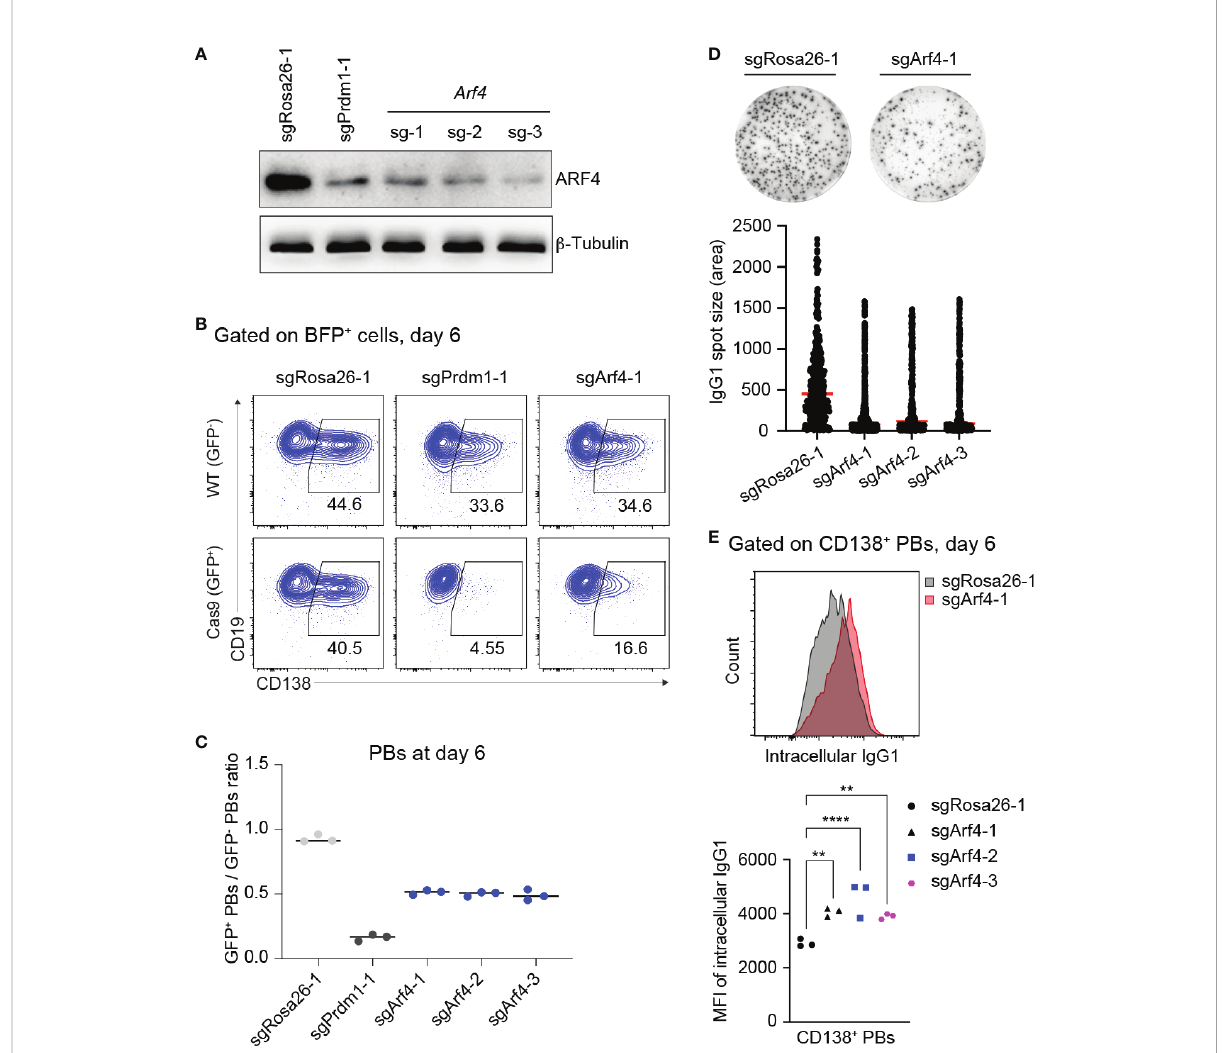
FIGURE 4 Loss of ARF4 arrests PB formation and blocks antibody secretion. (A) Western blotting for ARF4 protein showing gene KO ef fi ciencies of sgRNAs targeting the Arf4 gene. SgRosa26-1 and sgPrdm1-1 were used as negative and positive targeting controls. Beta-Tubulin was used as a loading control. (B) FACS analysis of PB differentiation six days post transduction, gates are set on CD138 + PBs in WT (GFP - , top) and Cas9 (GFP + , bottom) cells 6 days post transduction. (C) Scatter plot showing the ratio of GFP + (Cas9)/GFP - (WT) PBs corresponding to the experiment shown in (B) plus two biological repeat experiments. Each dot corresponds to one independent experiment averaged over two technical replicates; horizontal line indicates median. (D) Representative ELISPOT images showing antibody secretion in cells treated with indicated sgRNAs. Graph showing size (area) of IgG1 spots, quanti fi ed from a pool of 3 independent experiments. (E) Upper panel: Pre-gating on CD138 + PBs, FACS analysis showing expression levels of intracellular IgG1 in the cells targeted with sgRosa26-1 (grey) or sgArf4-1 (red). Lower panel: Scatter plot showing mean fl uorescent intensity (MFI) of intracellular IgG1 levels in cells transduced with the indicated sgRNAs (statistically signi fi cant difference is indicated: two-way ANOVA, p values are indicated (**, P<0.01; ****, P<0.0001). n=3 independent experiments with two technical replicates